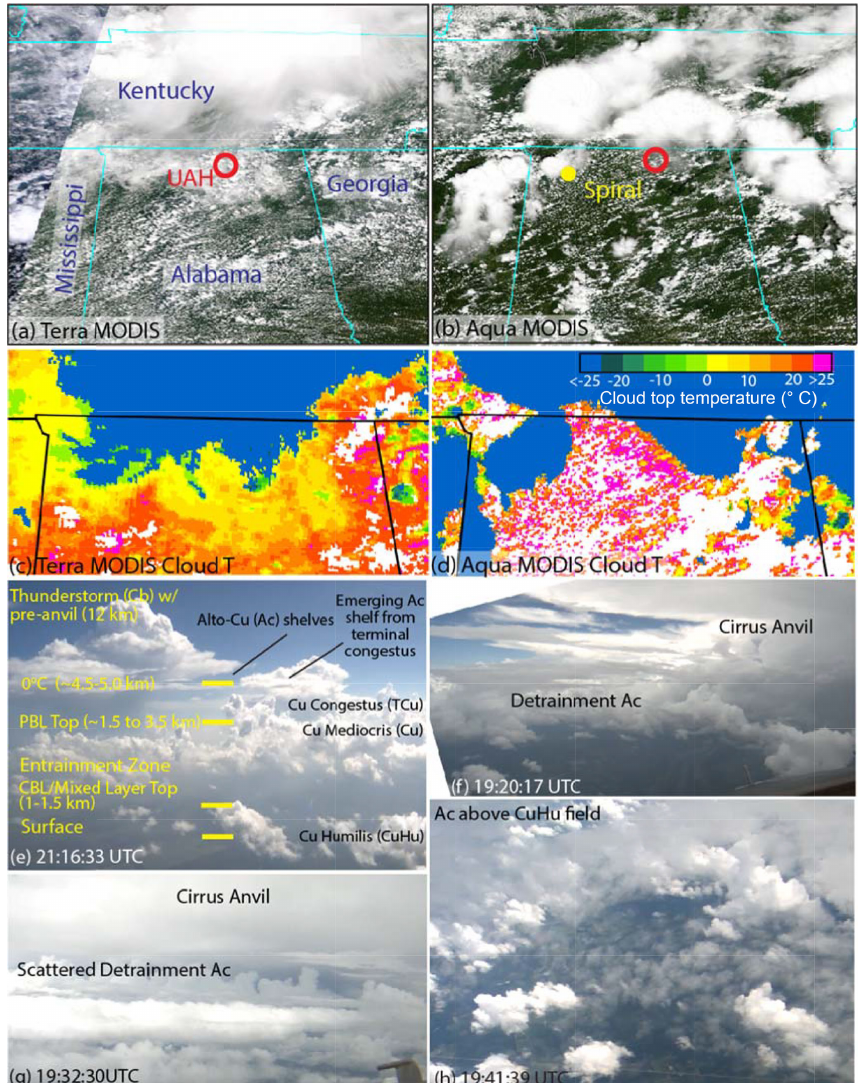
Figure 2. MODIS (a) Terra (16:00UTC) and (b) Aqua (19:14UTC) images, with markers indicating the location of the UAH lidar site (red) and DC-8 spiral (yellow) for 12 August 2013. Corresponding MYD06 cloud top temperatures zoomed onto northern Alabama are provided in (c) and (d) . Also included are annotated camera images from the NASA DC-8 demonstrating cloud type (e) image just after profile components end; (f) forward images as the DC-8 was about to enter a detrainment Ac at 4.4km; (g) forward image of the DC-8 while sampling the 6.5km aerosol layer; (h) nadir images of an Ac detrainment shelf exiting a Cb over a field of Cu. Image from NASA Worldview (https://worldview.earthdata.nasa.gov/, last access: 17 August